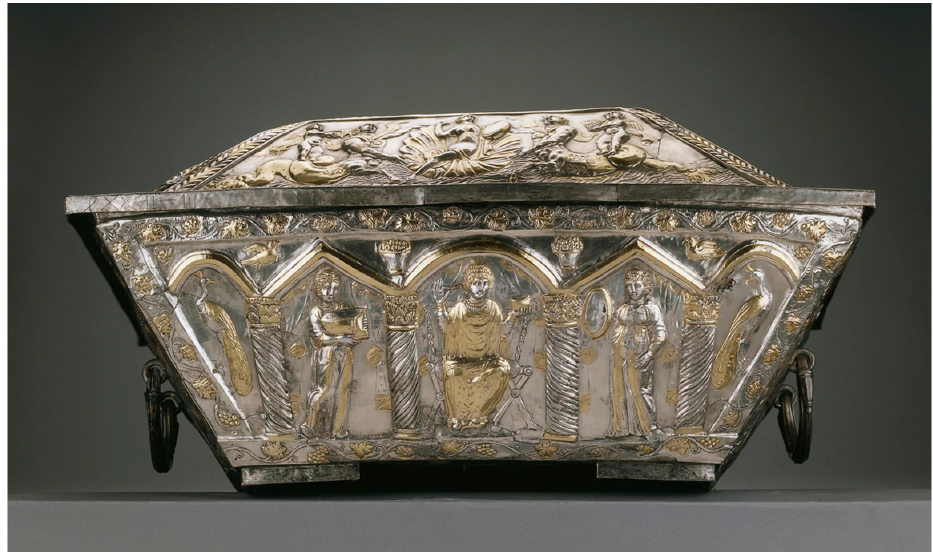
Figure 8. The Projecta Casket , c. 380 CE. Late Roman; Rome. Silver, gold; 28.6 × 56 × 48.8 cm (11 1/4 × 22 × 19 1/4 in.). The British Museum, 1866,1229.1. © The Trustees of the British Museum. Shared